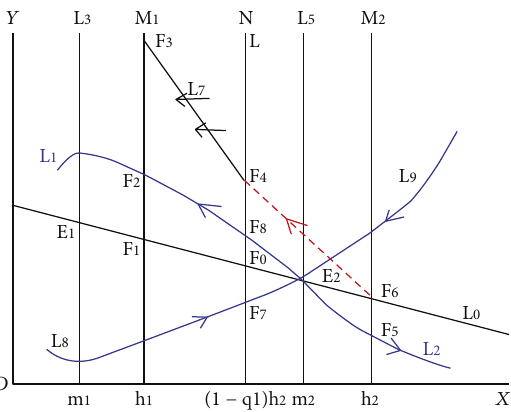
Figure 10: There exists an order-1 periodic solution of system (4) > y with 1 − p y . F 2 E 2